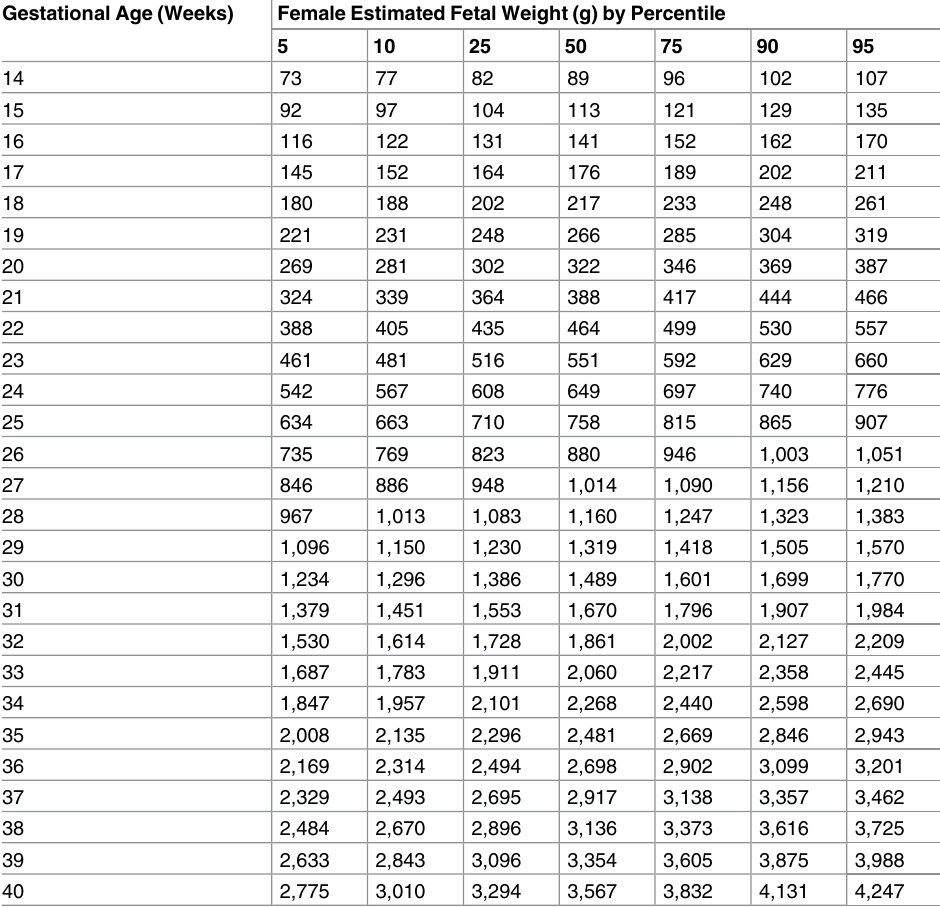
Table 14. Growth chart for estimated fetal weight for female